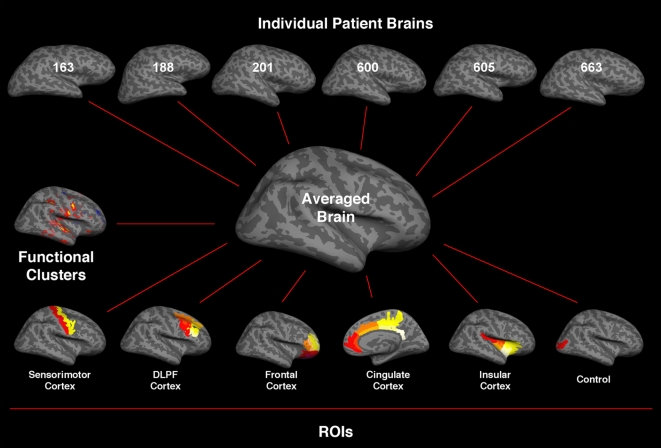
The upper six images show individual inflated brains, exposing sulci and gyri, of trigeminal neuropathic pain (TNP) patients affecting the right maxillary division (V2) of the trigeminal nerve.Each subject was scanned twice, for subsequent functional and structural data averaging, with a minimum of 3–6 months separating the scanning sessions. The middle inflated brain represents the averaged brain of the TNP patients based on the a common spherical atlas for each hemisphere aligning morphologically homologous gyri and sulci from each subject's brain; The midlle left image illustrates functional (de)activation during V2 allodynic stimulation, and the lower six images show regions of interest (ROIs) parcellated from the averaged to the individual brains independently. Subsequently, the cortical thickness differences (TNP versus healthy controls, and contralateral versus ipsilateral sides to the TNP (see Data S1) and underline functional activity where analyzed in five specific cortical ROIs. In addition, the Occipital Middle Sulcus was selected as a control cortical region.